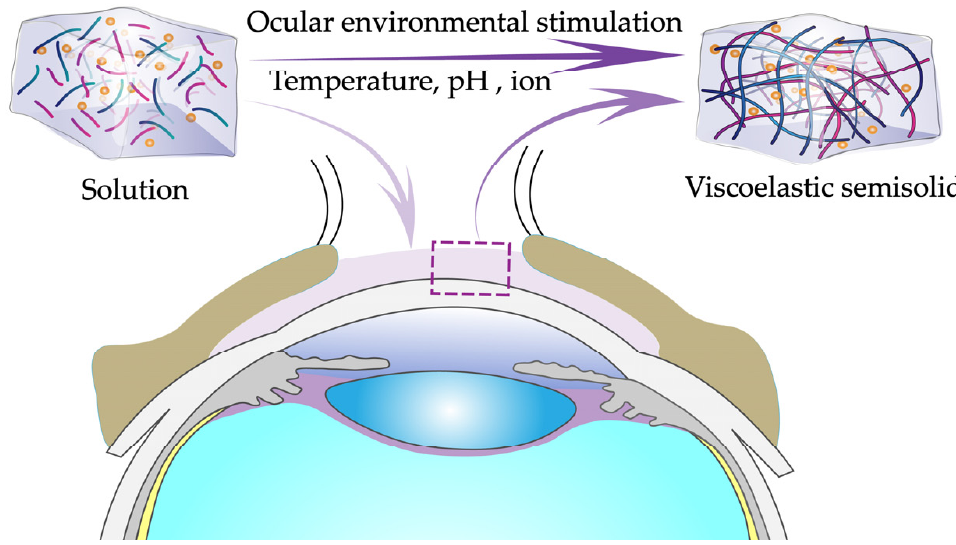
Figure 4. Diagram of in situ gel eye drops delivery systems in the eye.